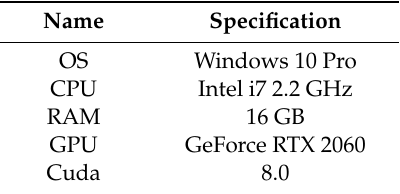
Table 1. Experimental environment.